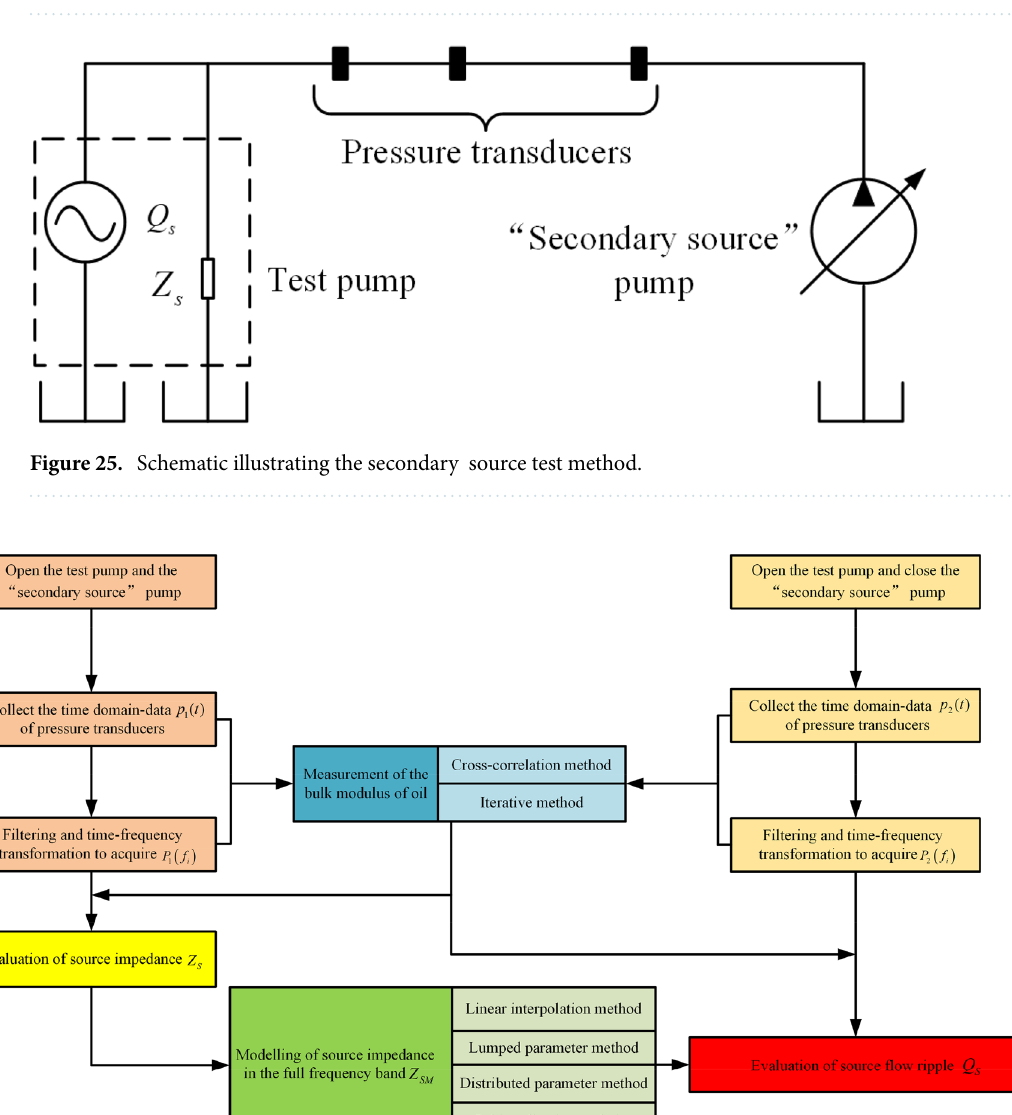
Figure 24. The variation of gas volume fraction in the rotor region with and without unloading groove.